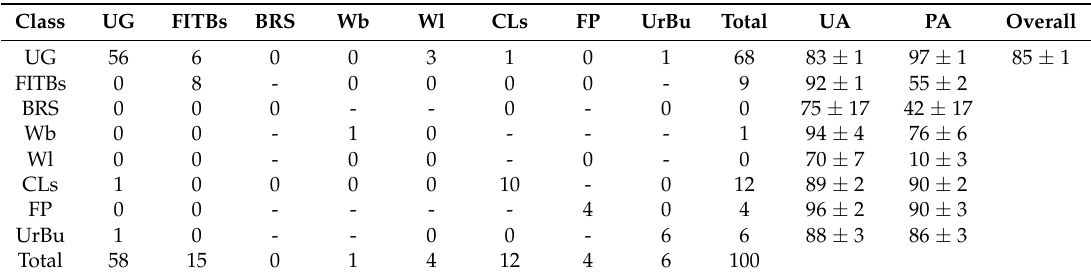
Table 7. Summarized accuracy assessment of DLC 2014 (T2) expressed as the estimated proportion of